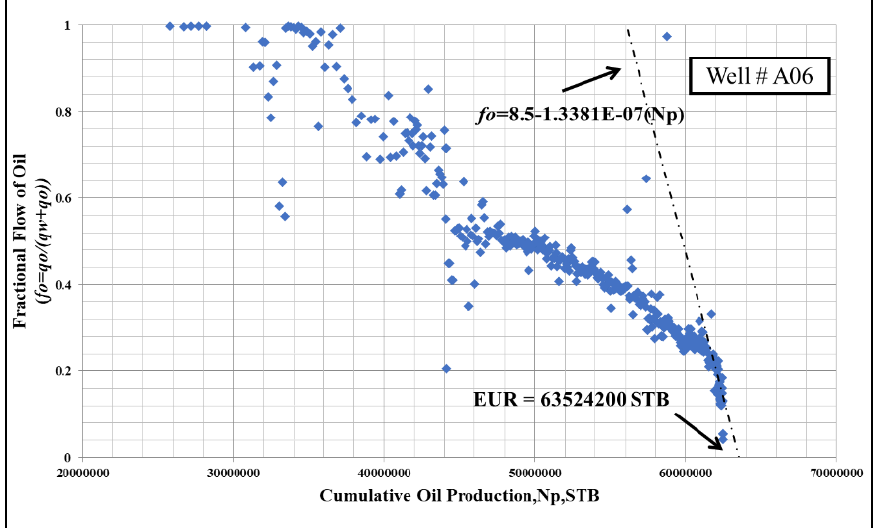
Figure 15. Fractional flow of oil versus cumulative oil production for well A06